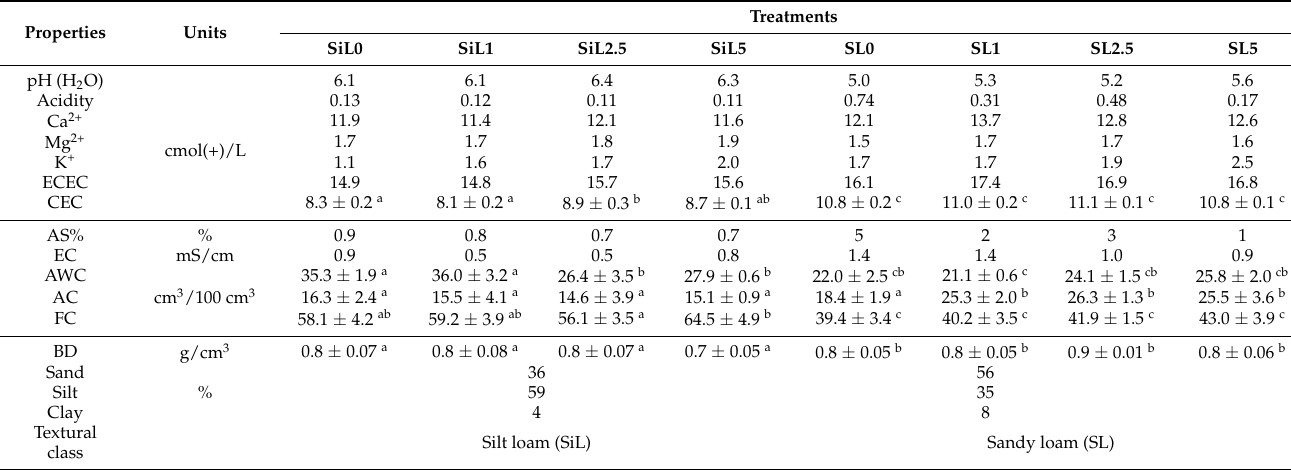
Table 3. Physical and chemical properties of biochar and the soil treatments silt loam (SiL) and sandy loam (SL) with 0, 1, 2.5 and 5% biochar